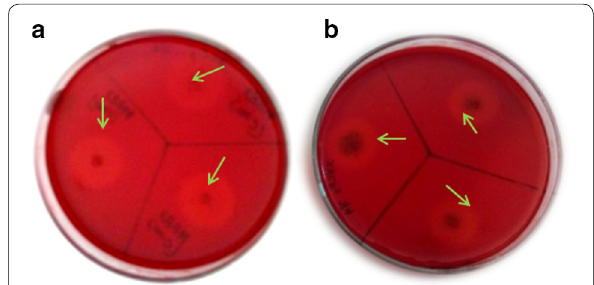
Fig. 2 a Cellulose and b xylan plates showing clearing zone by thermophilic bacterial isolates. The thermophilic bacterial isolates were grown on CMC agar and xylan agar plates respectively and incubated at 50 °C for 48 h. The plates were flooded with 0.1% congored followed by destaining with 1 M NaCl. The presence of a halo around the colonies represents hydrolytic activity, cellulolytic as well as xylanolytic respectively